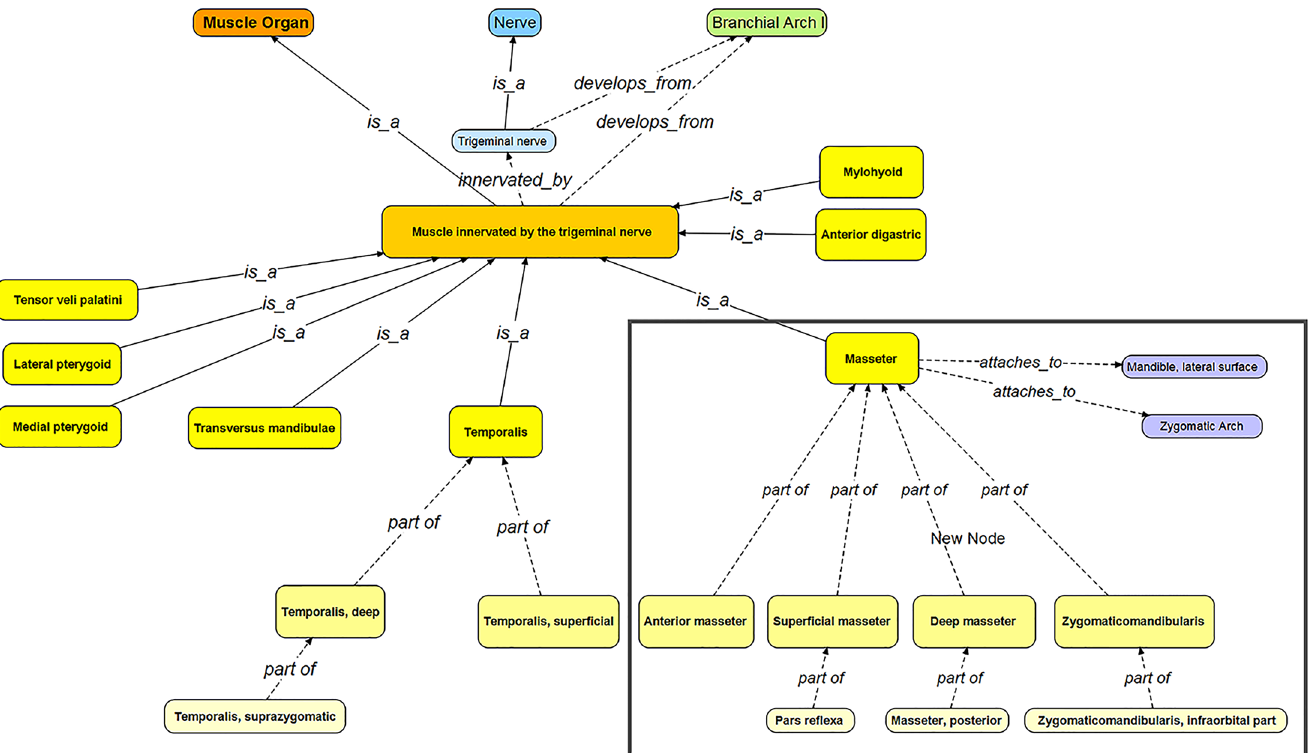
Fig 2. The structure of the trigeminal muscles in the MFMO. Ontological structure of muscles that develop from the first branchial arch/pharyngeal arch 1 and are innervated by the trigeminal nerve ( “ trigeminal muscles ” ) in the MFMO. The box indicates the masseter muscle, its parts, and its attachments. For simplicity, only the bony attachments of the masseter are